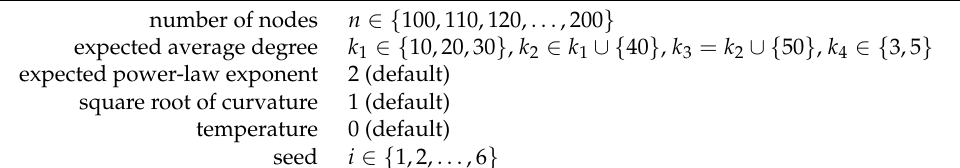
Table 1. Parameters of the used hyperbolic graph generator [87]. We set the number of vertices to a range in which the instances are tractable but challenging for the solver PID (cid:63) . The expected average degree is k 1 for n 100,110,120 , k 2 for n 130,140 , k 3 for n 150,160 , and k 4 ∈ { } ∈ { } ∈ { } for n 170,180,190,200 . For each combination of n and the corresponding k i , we generated six ∈ { } instances with random seed s 1, . . . ,6 yielding 210 instances. The remaining parameters of the ∈ { } generator are set to their default value. number of nodes